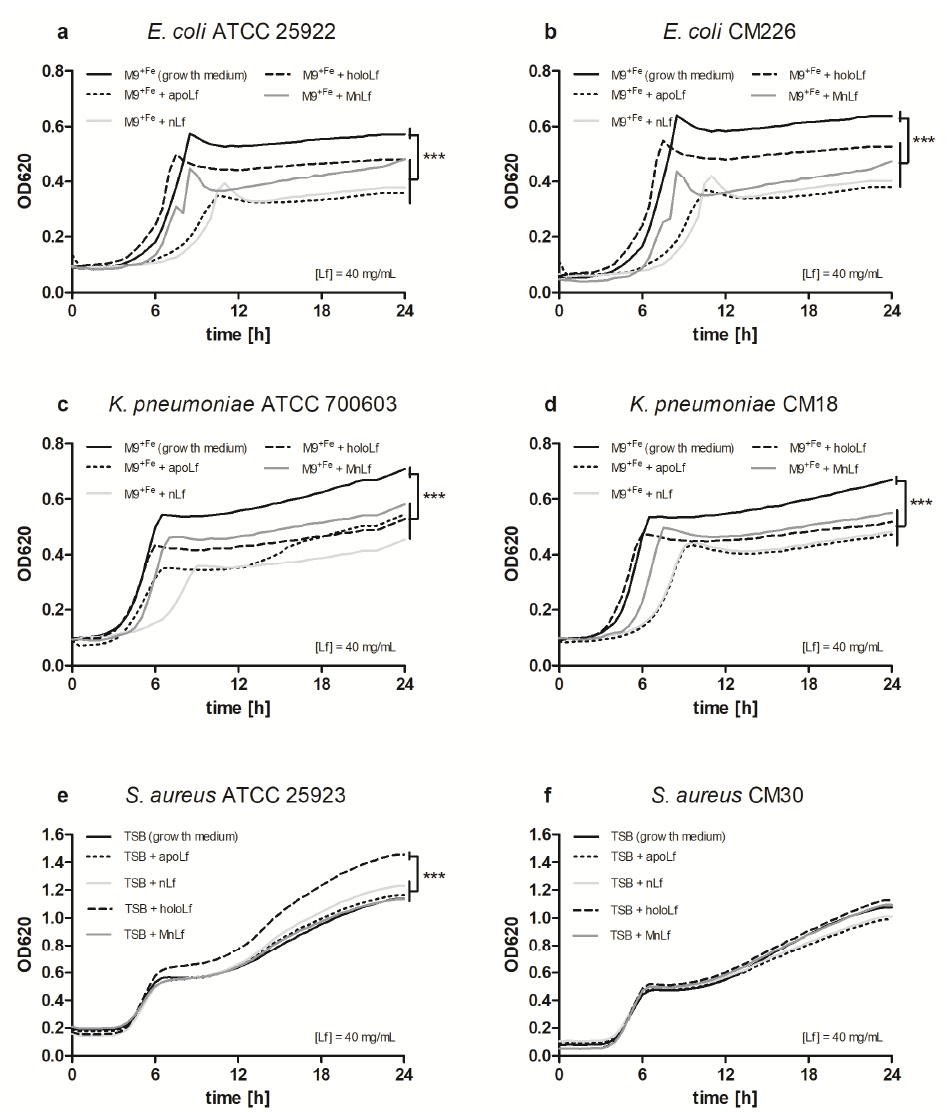
Figure 1. Semi-quantitative assessment of pathogenic bacterial growth upon incubation with various lactoferrin forms: Escherichia coli ATCC 25922 ( a ), E. coli CM226 ( b ), Klebsiella pneumoniae ATCC 700603 ( c ), K. pneumoniae CM18 ( d ), Staphylococcus aureus ATCC 25923 ( e ), S. aureus CM30 ( f ). Statistical significance was evaluated using one-way ANOVA, *** p < 0.001. Lf, lactoferrin; apoLf, apolactoferrin; holoLf, hololactoferrin; nLf, native lactoferrin; MnLf, manganese-saturated lactoferrin; TSB, tryptic soy broth .